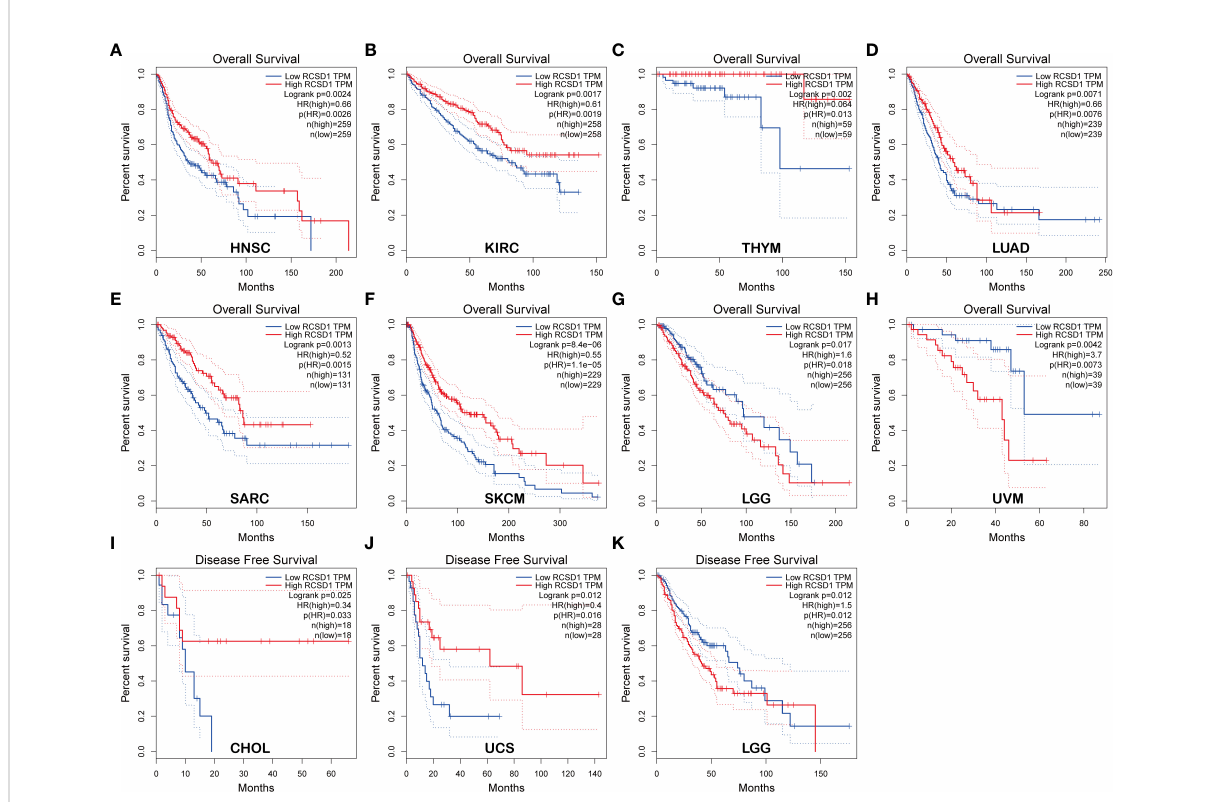
FIGURE 2 Relationship between RCSD1 expression and patient survival using GEPIA. Relationship between RCSD1 expression and OS of (A) HNSC patients, (B) KIRC patients, (C) THYM patients, (D) LUAD patients, (E) SARC patients, (F) SKCM patients, (G) LGG patients, and (H) UVM patients. Relationship between RCSD1 expression and RFS of (I) CHOL patients, (J) UCS patients, and (K) LGG patients. OS, Overall Survival; RFS, Disease Free